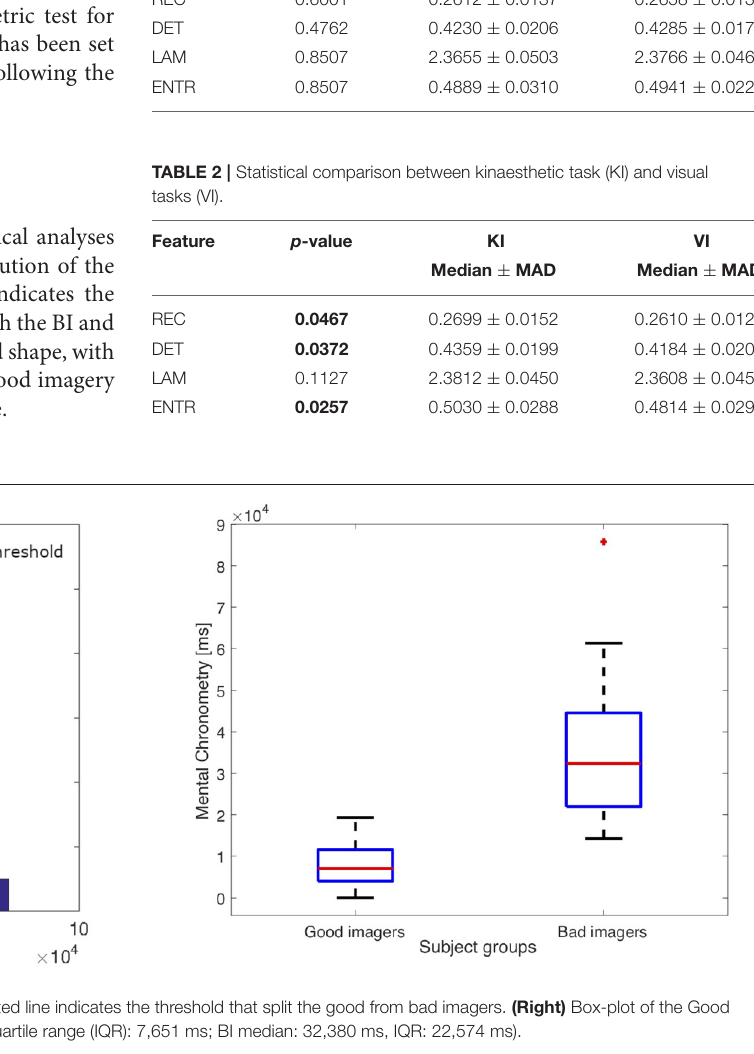
Frontiers in Neuroscience |